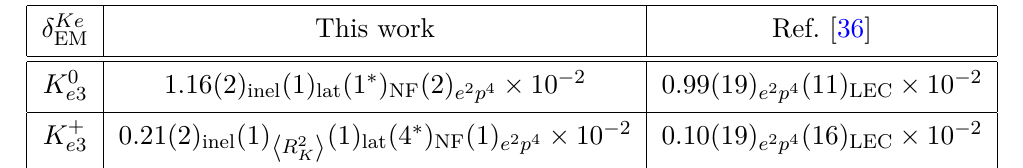
Table 6 . Comparison between the value of δ Ke